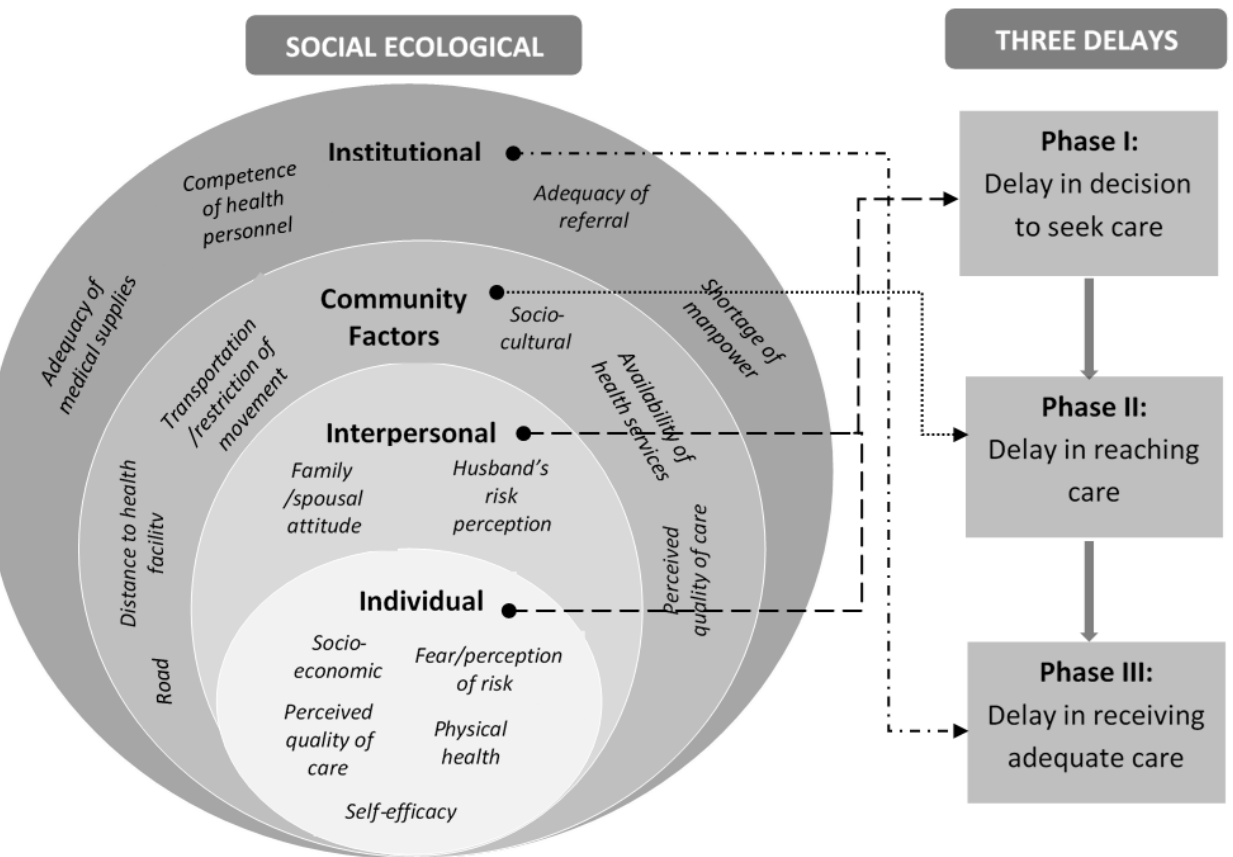
Figure 1. Summary of interactions between the social ecological model, three delays model and utilization of MNCH services.